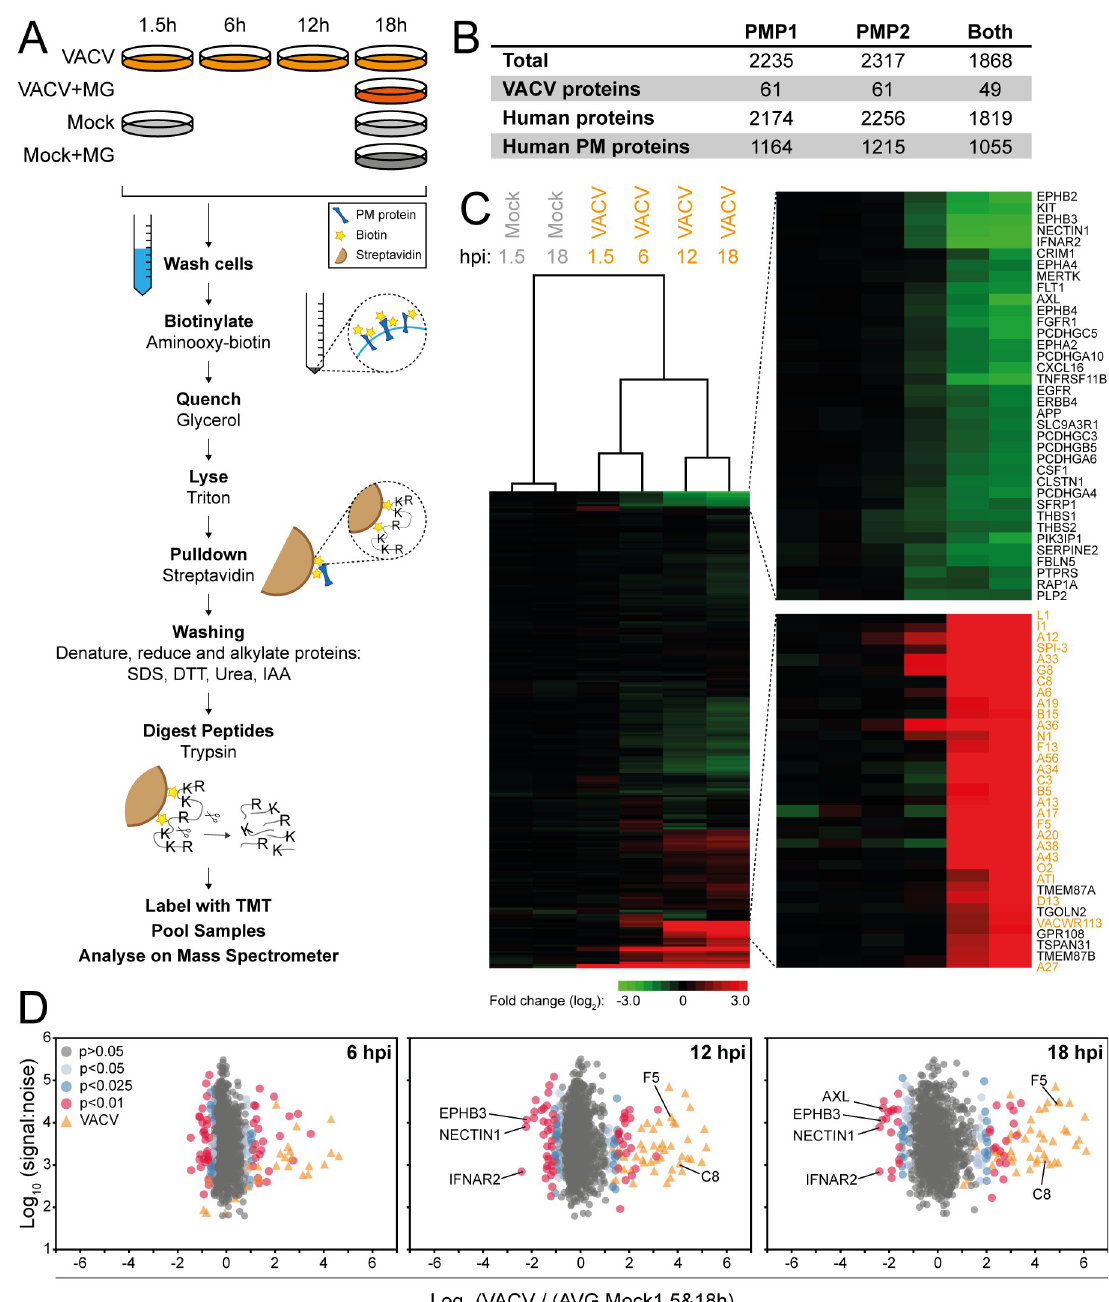
Fig 1. Quantitative temporal analysis of the plasma membrane proteome during VACV infection. ( A ) Schematic of the experimental workflow. HFFF-TERTs were mock-treated or infected with VACV at MOI 5 for the indicated time-points (S1A and S1B Fig). At 2 hpi MG132 was added to a mock and an infected sample (‘+MG’). Samples were generated in biological duplicate (PMP1, PMP2). ( B ) Number of proteins quantified in the PMP replicates. ‘Human PM proteins’ represents the number of proteins annotated with relevant GO terms (PM, ‘cell surface’ [CS], ‘extracellular’ [XC] and ‘short GO’ [ShG, 4-part term containing ‘integral to membrane’, ‘intrinsic to membrane’, ‘membrane part’, ‘cell part’ or a 5-part term additionally containing ‘membrane’]). ( C ) Hierarchical cluster analysis showing the fold change of all VACV and human proteins quantified in both replicates compared to mock (average 1.5 and 18 h, S1C Fig). Selected sections are shown enlarged and VACV proteins are indicated in orange. ( D ) Scatter plots of all VACV and human PM proteins quantified in both repeats at 6, 12 or 18 hpi. Selected human PM proteins were annotated. P-values were estimated using significance A with Benjamini-Hochberg correction for multiple hypothesis testing [117].